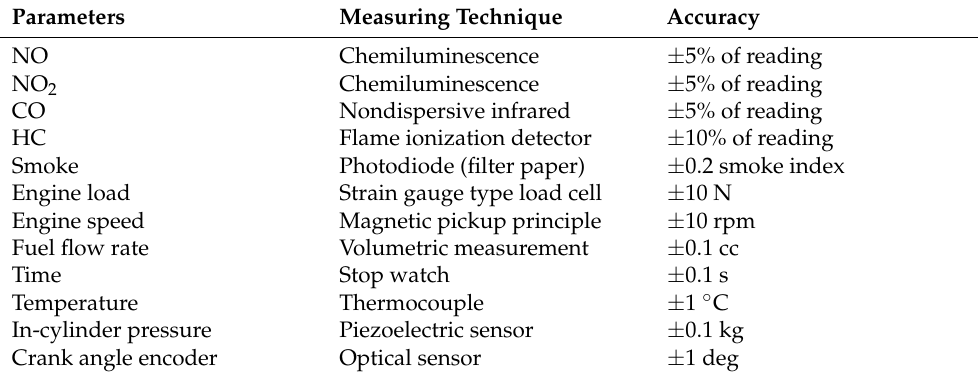
Table 2. Technical specification of measuring